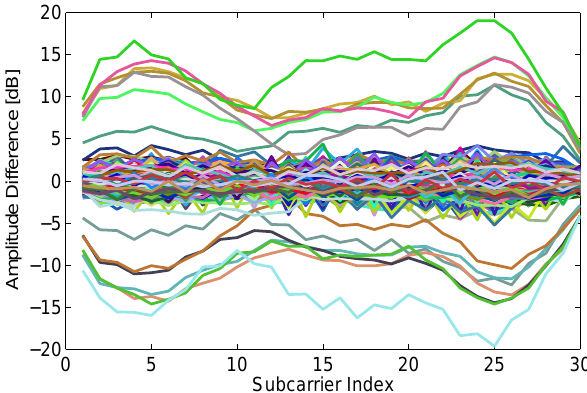
Figure 3. Amplitude differences between adjacent packets in the dynamic